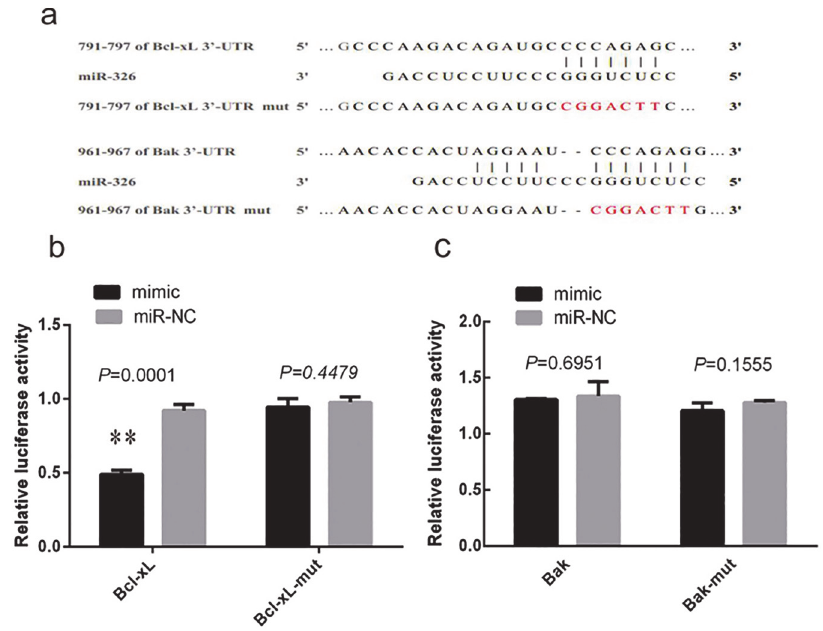
Fig 1. MiR-326 targets the 3 0 -untranslated region (UTR) of Bcl-xL but not that of Bak. ( a ) Putative miR- 326 binding sequences in the 3 0 -UTR of the Bcl-xL and Bak genes and the mut sequences. ( b ) Transfection of miR-326 mimic compared to the negative control (miR-NC) significantly inhibited luciferase activity from a reporter vector containing the 3 0 -UTR of Bcl-xL ( ** P < 0.01). However, there was no inhibition of a reporter vector with mutations in the miR-326-binding site (Bcl-xL-mut) ( P > 0.05). ( c ) Transfection of miR-326 did not significantly reduce the luciferase activity from reporter vectors containing the 3 0 -UTR of Bak or Bak-mut ( P > 0.05). Results represent the means ± SD of luciferase values in 3 independent experiments and are normalized to 1.0 for the miR-NC